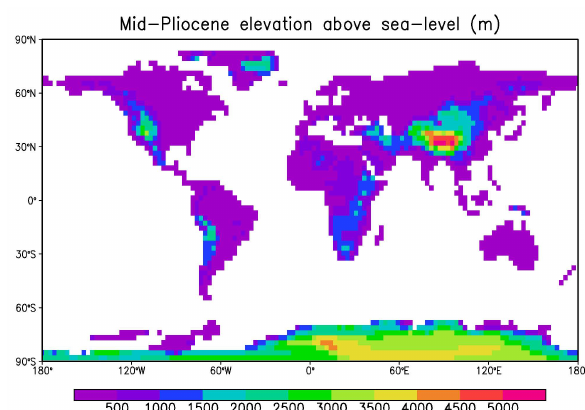
Fig. 2. Surface height above sea-level in the mid-Pliocene experi-